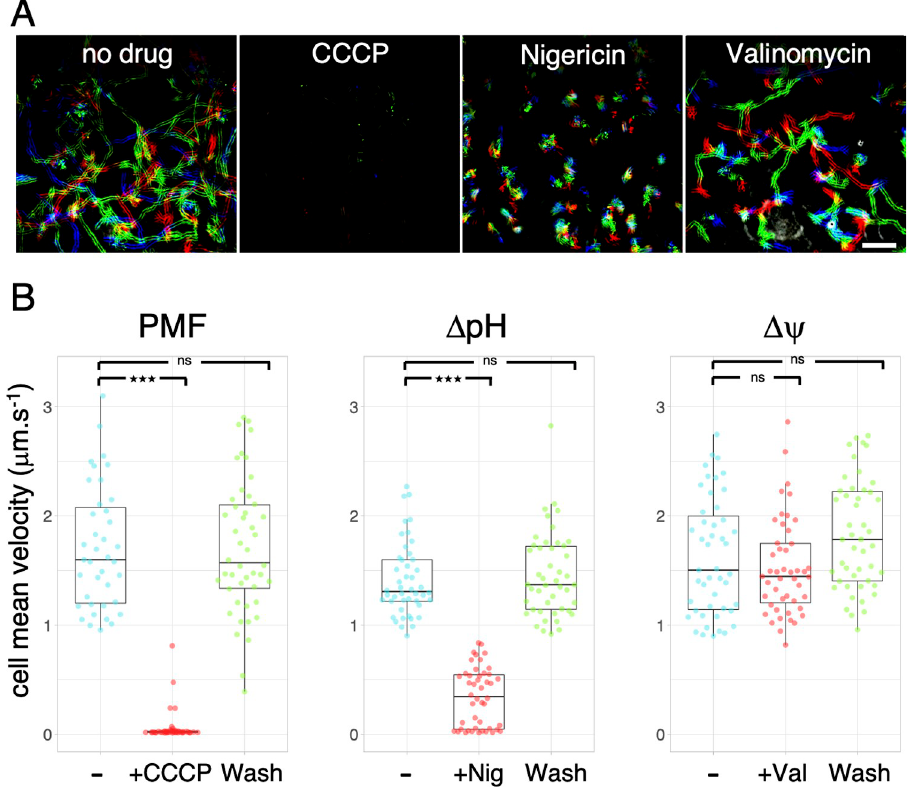
Fig 1. Effects of PMF dissipating drugs on F . johnsoniae cells gliding. (A) Rainbow traces of cell motility on glass recorded by phase contrast microscopy over time (2 minutes) in the absence of drug or in the presence of CCCP, nigericin, or valinomycin. Individual frames from time-lapse acquisition were colored from red (start) to yellow, green, cyan, and blue (end) and merged into a single rainbow image. Scale bar, 20 μ m. (B) Combined jitter plots/boxplots of mean cell gliding velocity (in μ m.s − 1 ) of n > 38 WT cells before ( − ), during a pulse of 10 μ M CCCP (+CCCP), or 7 μ M nigericin (+Nig), or 40 μ M valinomycin/+50mM KCl (+Val), and after wash with fresh CYE medium (Wash). Statistical significance relative to the nontreated condition ( − ) is indicated above the plots (ns, nonsignificative; ��� , p < 0.001; Wilcoxon t test). Data underlying this figure can be found in S1 Data. CCCP, carbonyl cyanide m- chlorophenyl hydrazone; PMF, proton motive force; WT, wild-type.